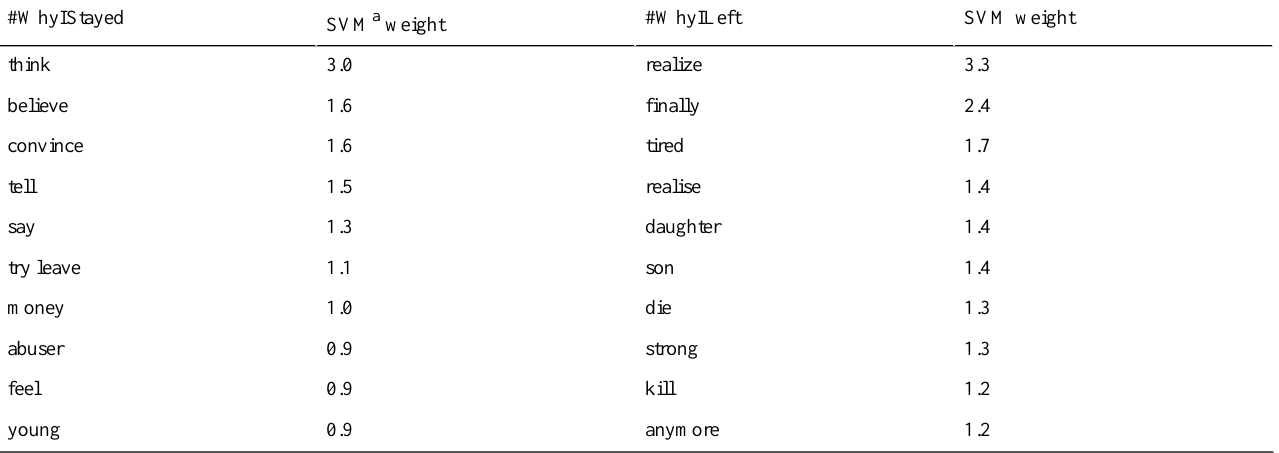
Table 6. Top 10 features, with their linear support vector machine weights using ngrams and retweet counts as features, and informal register replacement during preprocessing. Except for try leave , the top features were all